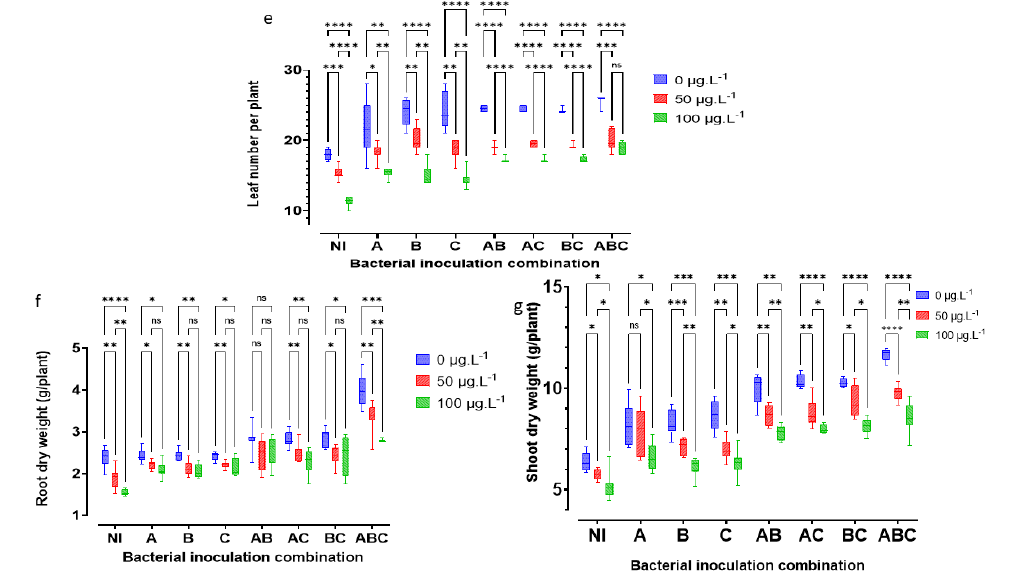
Figure 6. Detrimental impact of MC and beneficial effects of bacterial addition on leaf number per plant, NLP, ( e ); root dry weight, RDW, in g/plant ( f ); and shoot dry weight, SDW, in g/plant ( g ). The letters NI correspond to the sterile control without bacteria. A = SLB1 is the strain isolated from the Microcystis bloom, B = SLB3 is the strain isolated in MC-contaminated water, and C = RTC10 is the strain isolated in agricultural MC-contaminated soil. The stars correspond to statistical significance at different levels as ns= not significant; * = p < 0.05; ** = p < 0.01; *** = p < 0.001; **** = p <